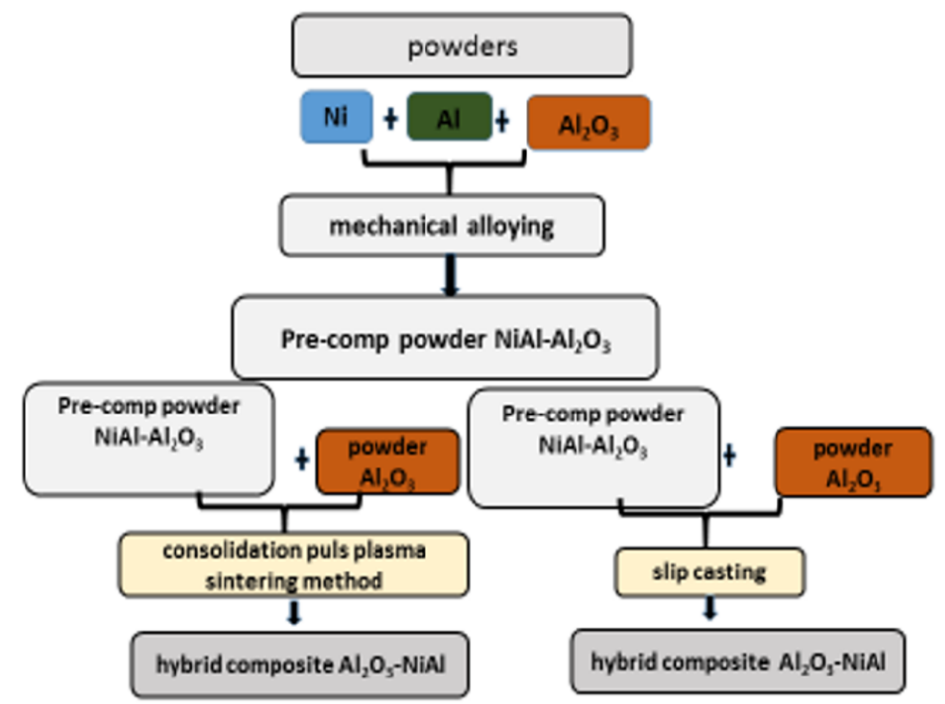
Figure 7. Schematic diagram of technological steps of bulk composite fabrication.